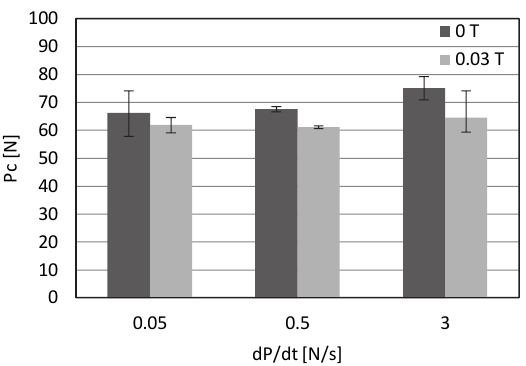
Figure 2: Mean fracture loads as a function of the loading-rate and the magnetic